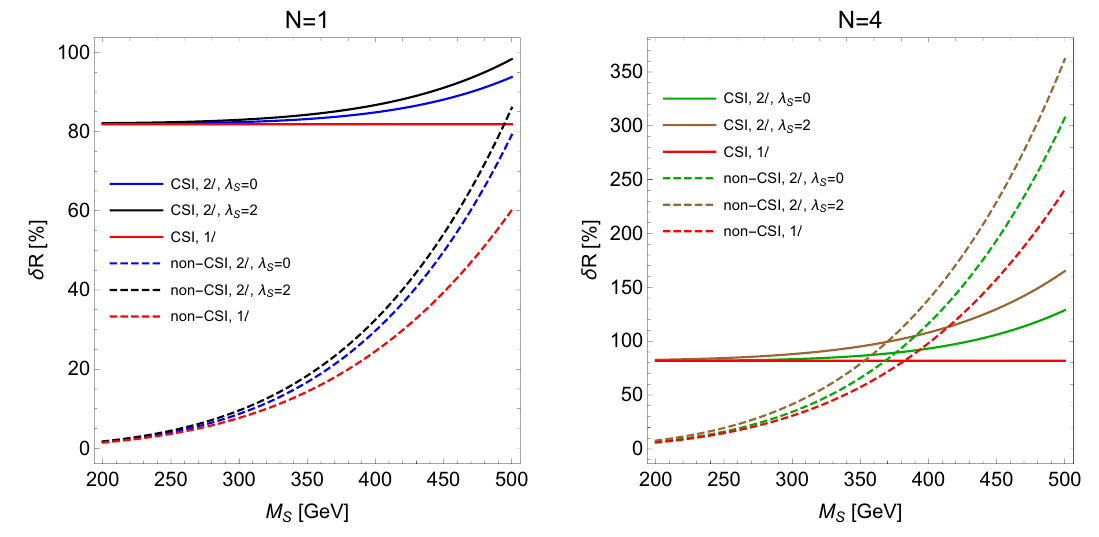
Figure 4 . Comparison of the BSM deviations δR computed in O ( N ) -symmetric models, with (solid curves) and without (dashed curves) CSI, as a function of the pole mass M S of the BSM scalars. Results for N = 1 and N = 4 are shown respectively in the left- and right-hand plots. Red curves are one-loop values, blue and green curves are two-loop results for λ S = 0 (respectively for N = 1 and N = 4 ), and black and brown curves are two-loop results for λ S = 2 (respectively for N = 1 and N = 4